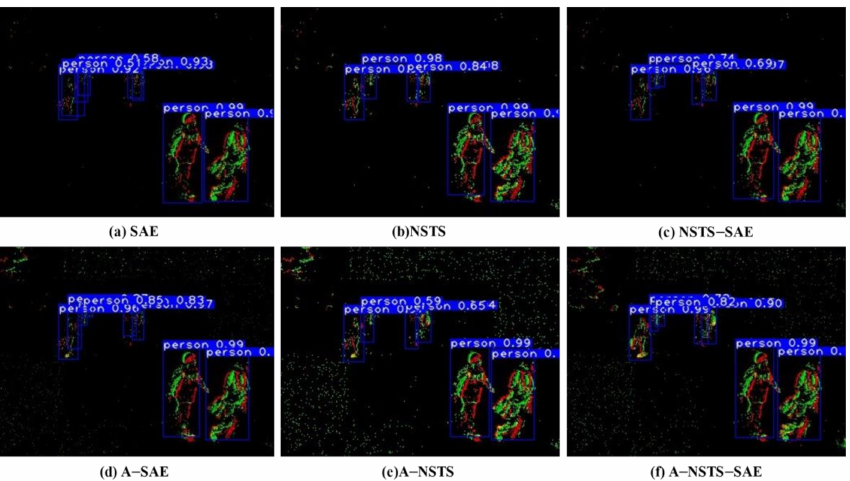
Figure 6. Some examples of visualization results of pedestrian detection. The outputs from EBD (event-based detector) are shown in the upper row, while outputs from EBD–AGP(asynchronous event frame detection model) are shown in the lower row. ( a ) SAE [14,15]; ( b ) NSTS; ( c ) NSTS–SAE; ( d ) A–SAE; ( e ) A–NSTS; ( f )